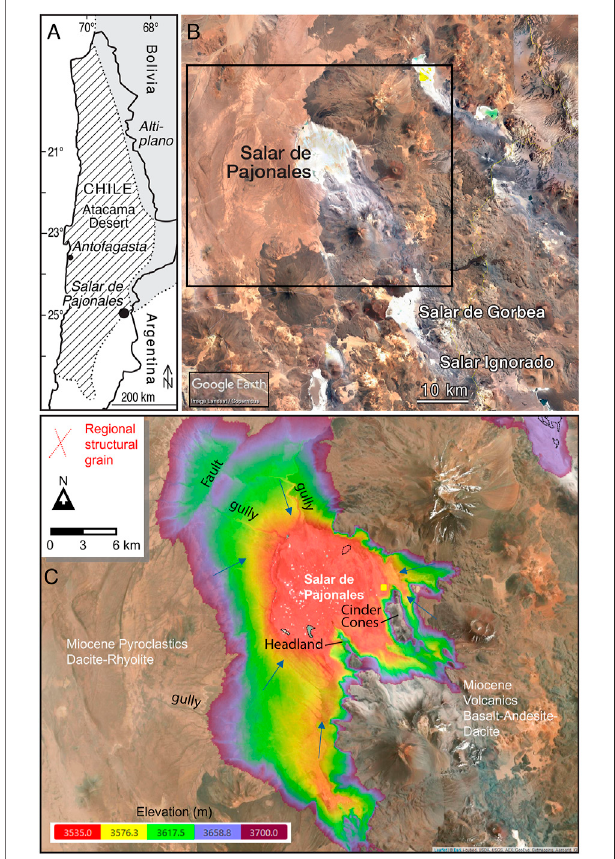
FIGURE 1 | Location of study area. (A) Map of Chile. (B) Overview of Salar de Pajonales. (C) Truncated digital elevation model (DEM) of the study site composed in the Cartalytics (www.cltix.com) spatial data software; aerial imagery is downloaded from the Lea fl et open-source library (https:// lea fl